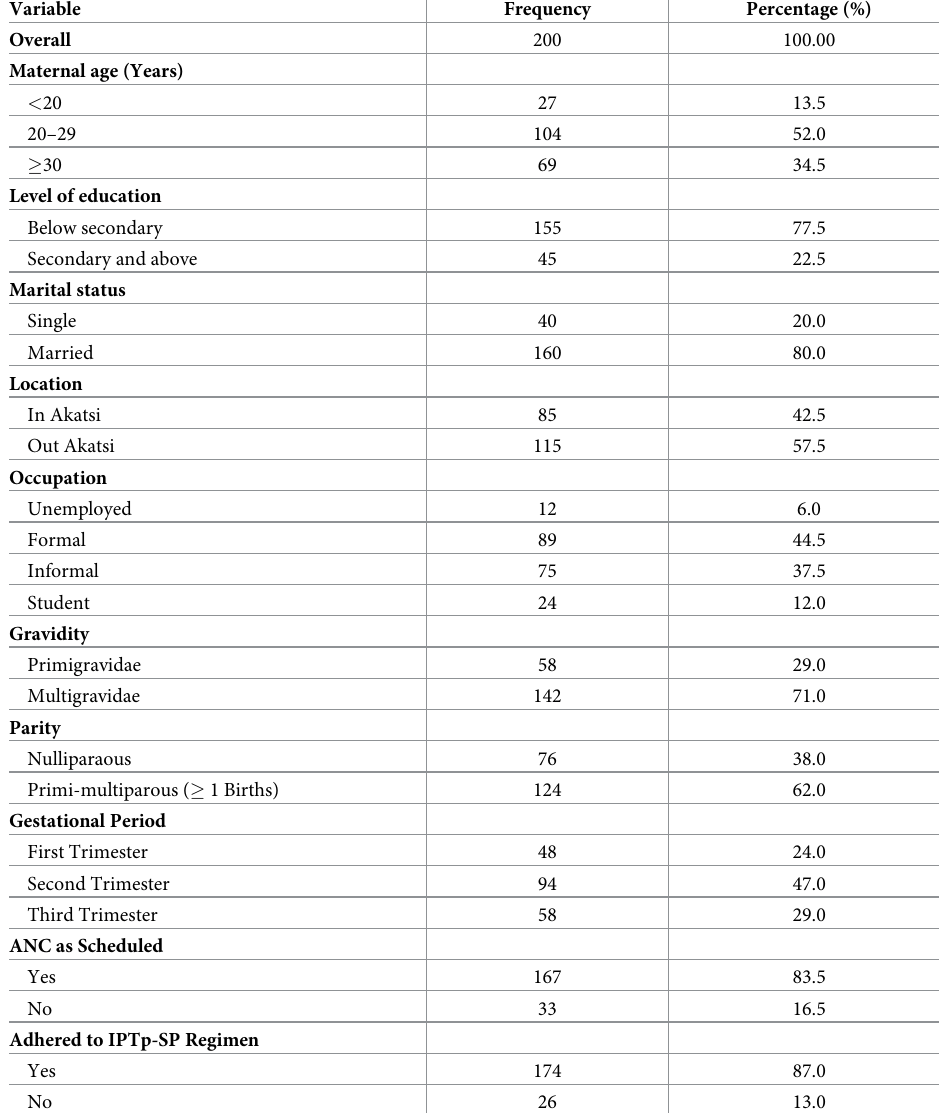
Table 1. Socio-demographic and clinical characteristics of the pregnant women, Akatsi South District,